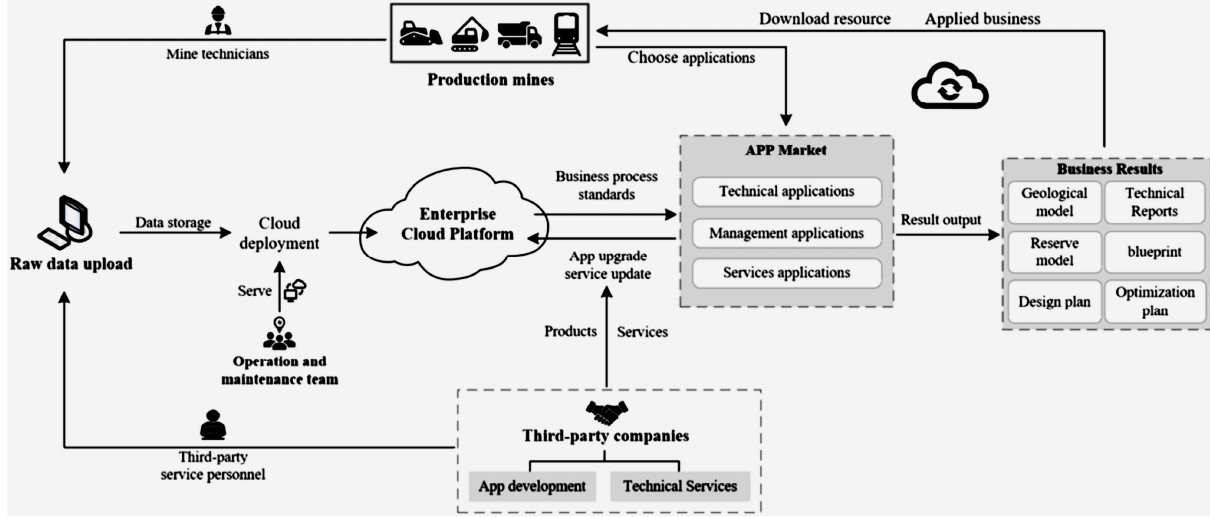
Figure 23. A mine production and operation management scenario under mode (Reprinted from Ref. [124]).